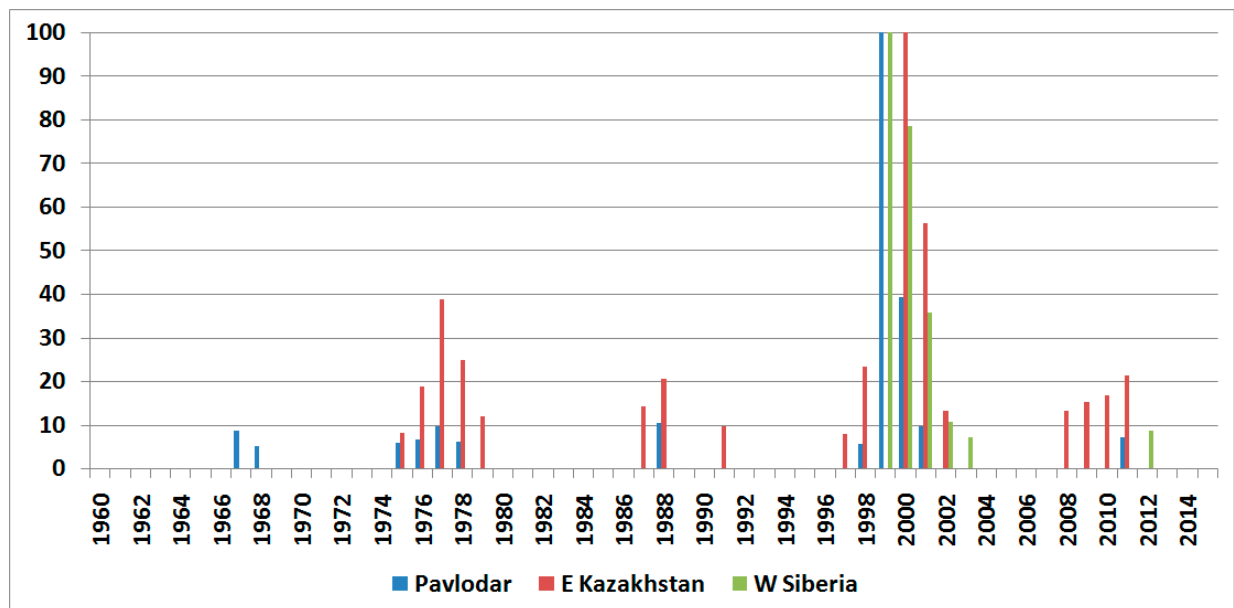
Figure 6. Long-term dynamics (1960–2015) of the Italian locust infestations in West Siberia (Altaj, Novosibirsk and Omsk Regions of Russia) and in the Pavlodar and East Kazakhstan Regions of Kazakhstan (% of the maximal registered infested areas [9]).